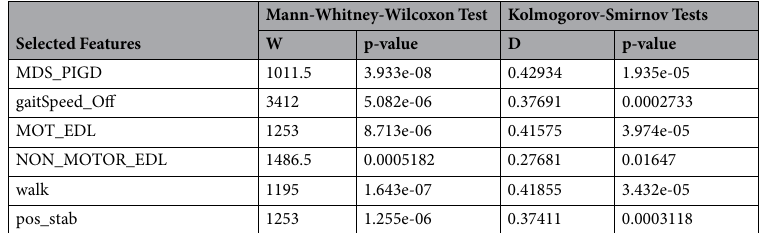
Table 5. MWW test and KS tests of group differences performed on the commonly selected features.